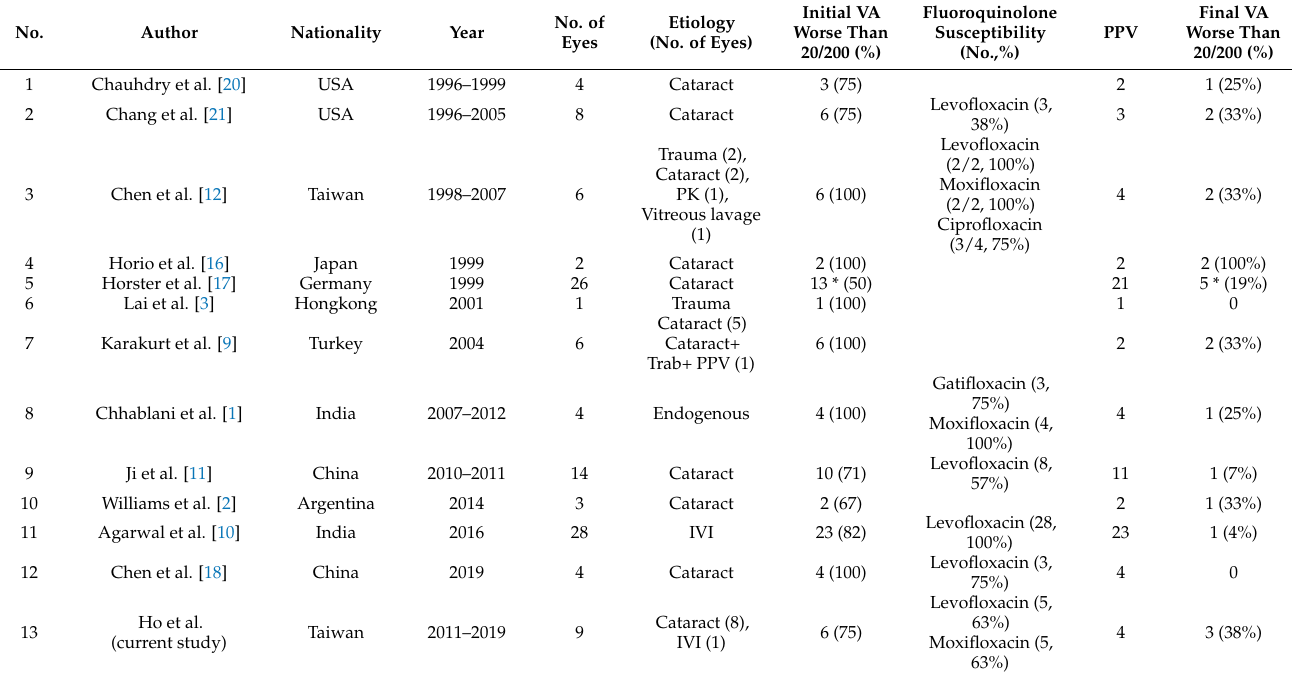
Table 4. Comparison of Stenotrophomonas maltophilia Endophthalmitis in the Literature and the Present